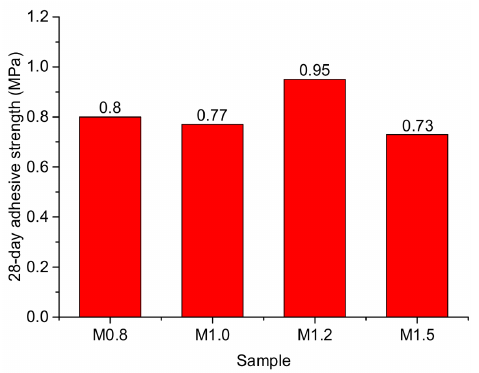
Figure 10. Adhesive strength at the age of 28 days.